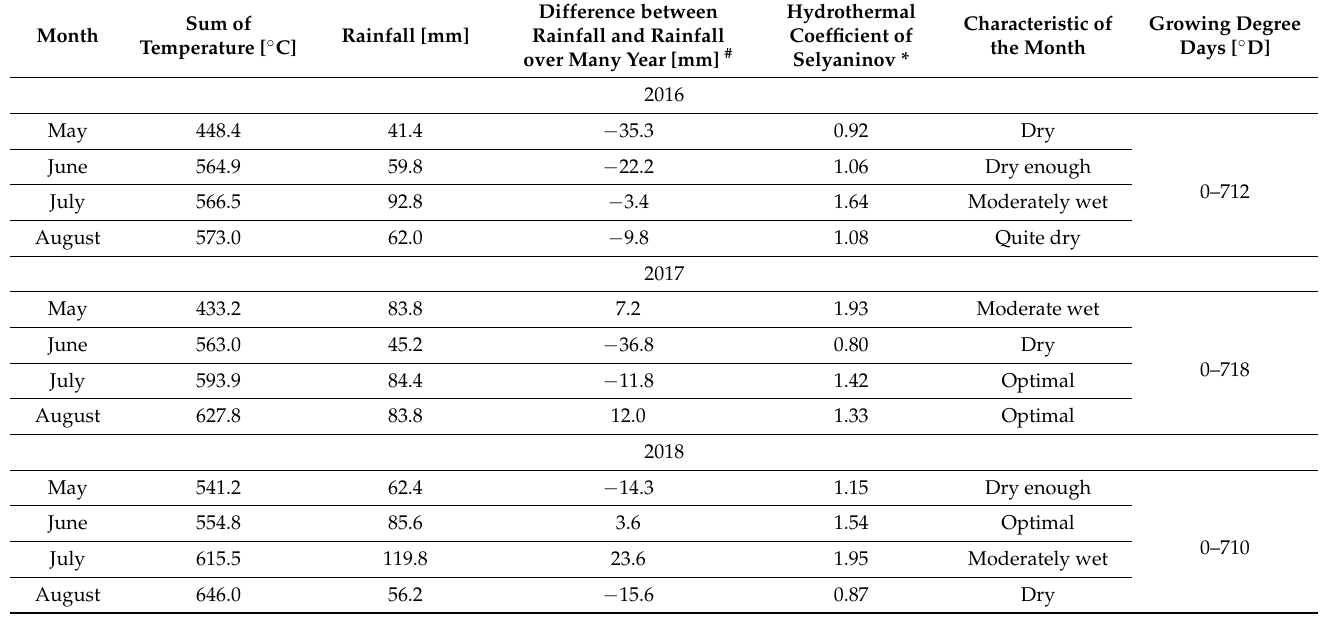
Table 2. Rainfall, air temperature, hydrothermal coefficient of Selyaninov and growing degree